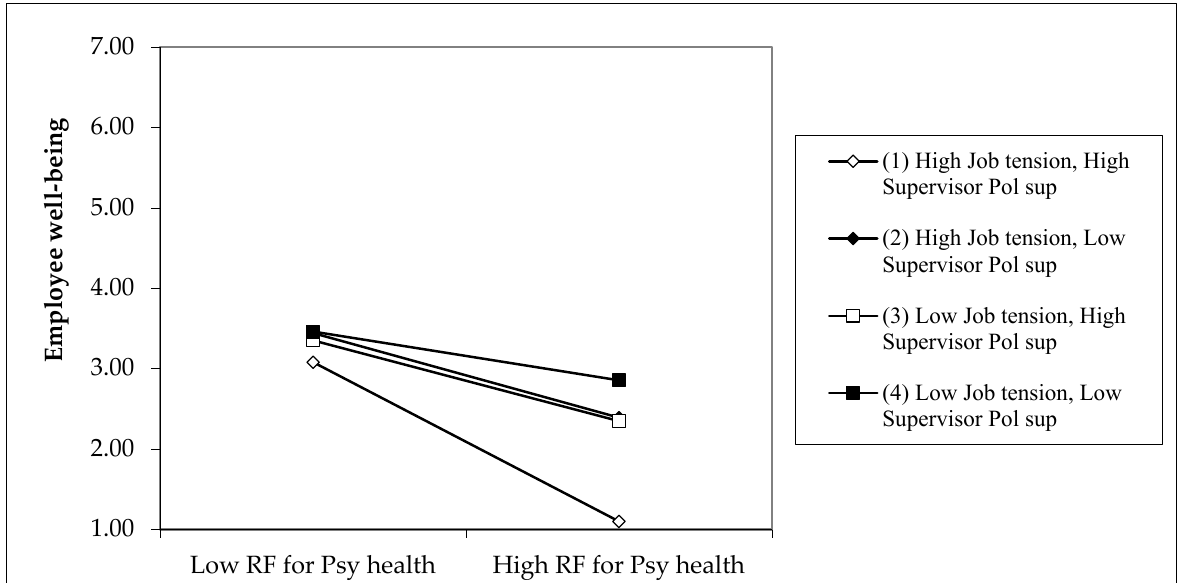
Figure 2. Sample 2: Three-way interaction of risk factors of work on psychological health, job tension, and supervisor political support predicting employee well-being. Note: Calculations are based on coefficients from Table 3 .